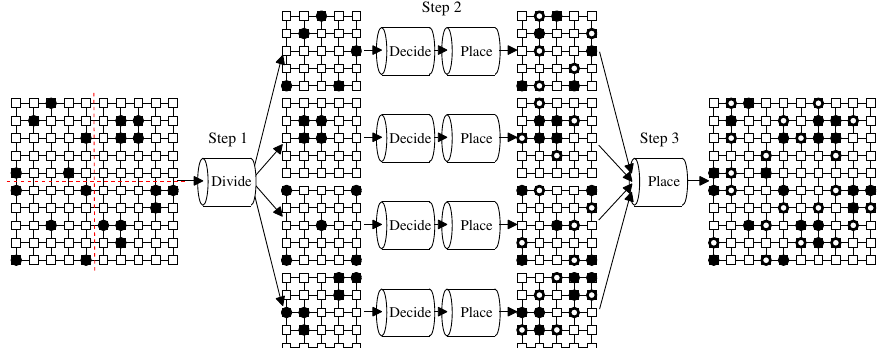
Figure 2. The operation of Procedure W ORM -L AUNCHER . After dividing a given 10 × 10 network into four 25 × 25 subnetworks, for each subnetwork, the Launcher predicts the placement of white-hat worms by machine learning